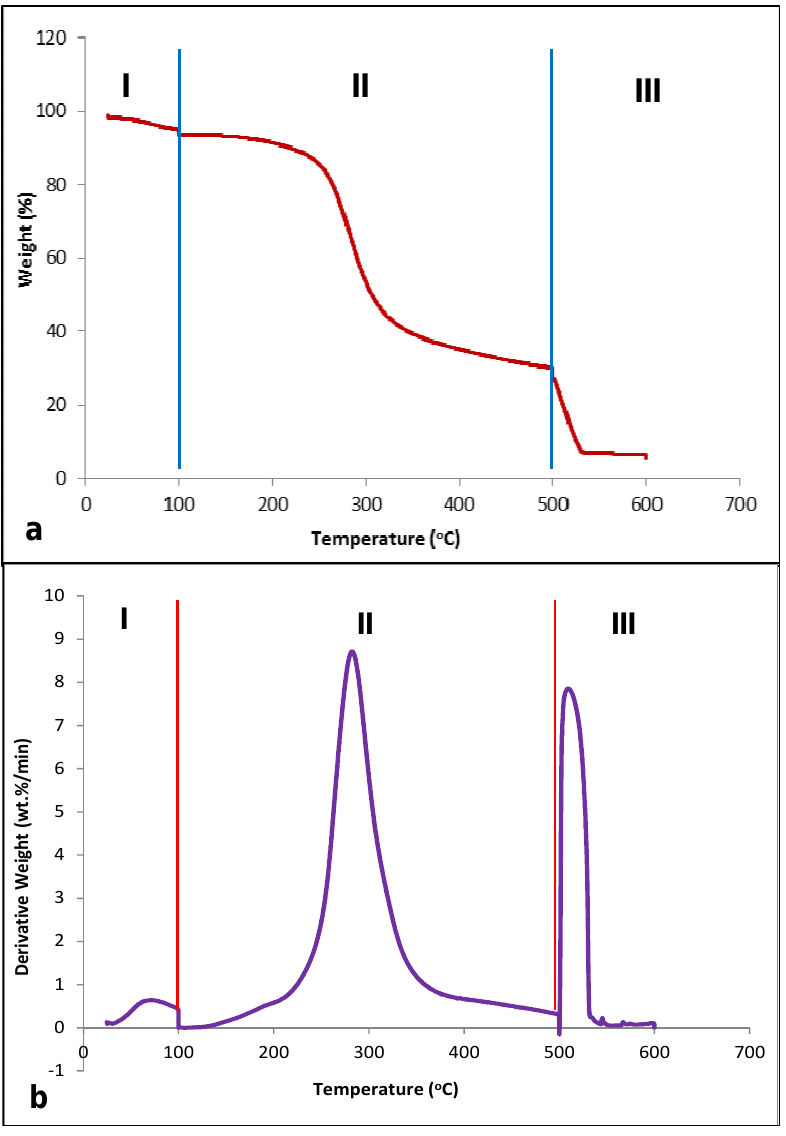
Figure 6. Thermogravimetric ( a ) and derivative thermogravimetric ( b ) analysis of YTBS in N 2 (I-II) and air (III) environments.